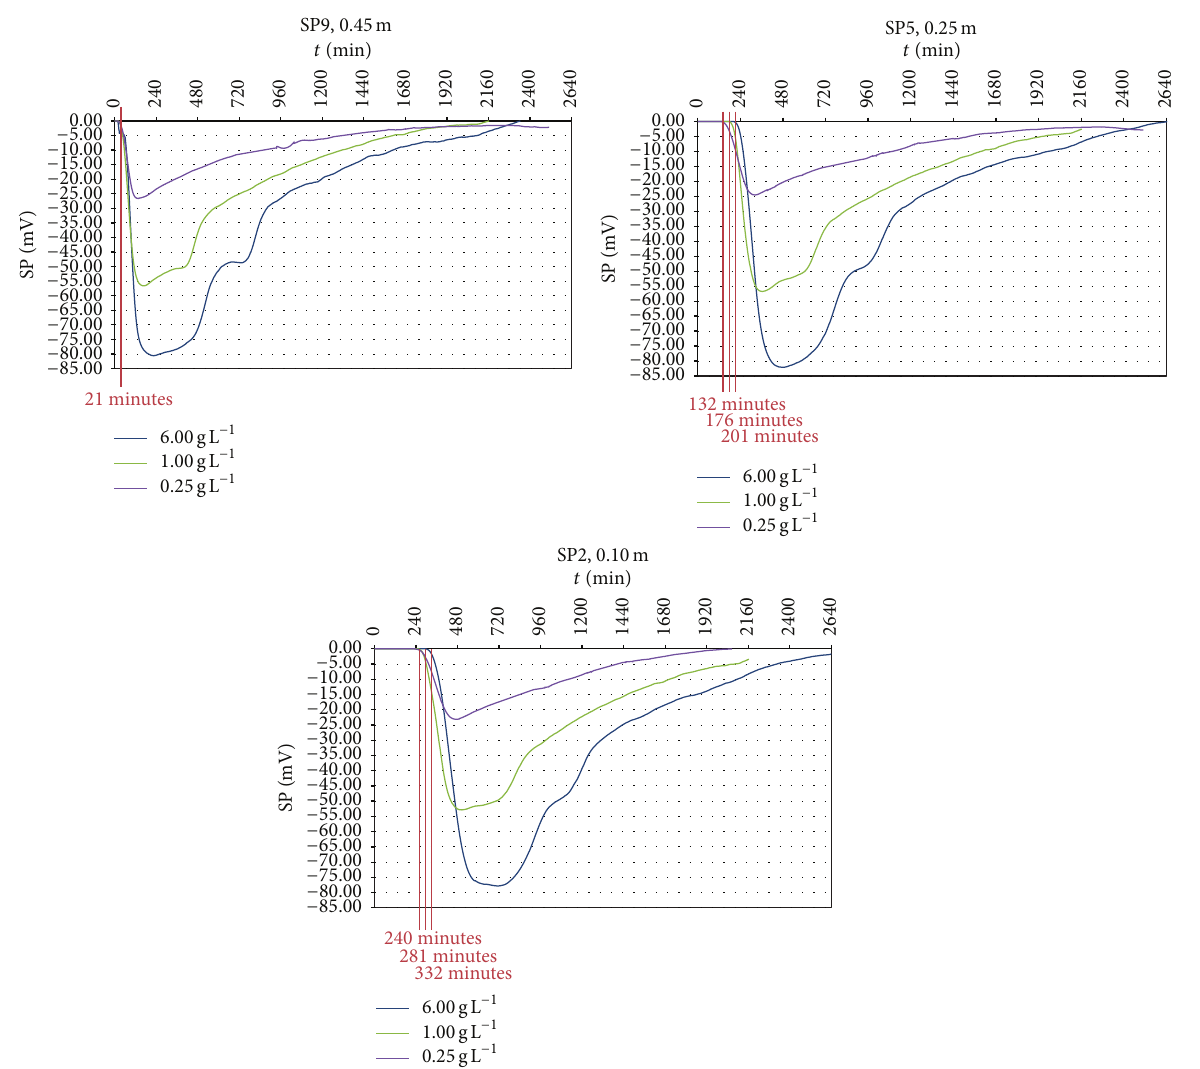
Figure 6: Comparison between SP values measured at different salt solution concentration (blue = 6.00 gL −1 , green = 1.00 gL −1 , and violet = 0.25 g L −1 ), at three different positions of the column. The red lines indicate the arrival time of the saline front at the electrodes.